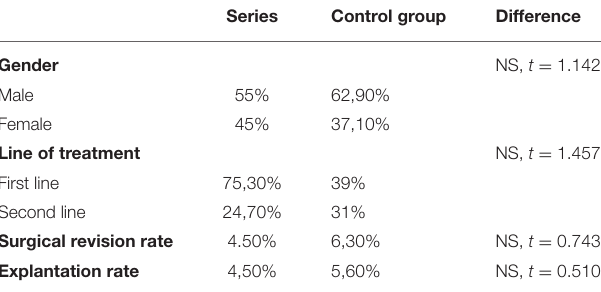
TABLE 2 | Summary of statistical differences between the clinical series considered in this study and the control group.